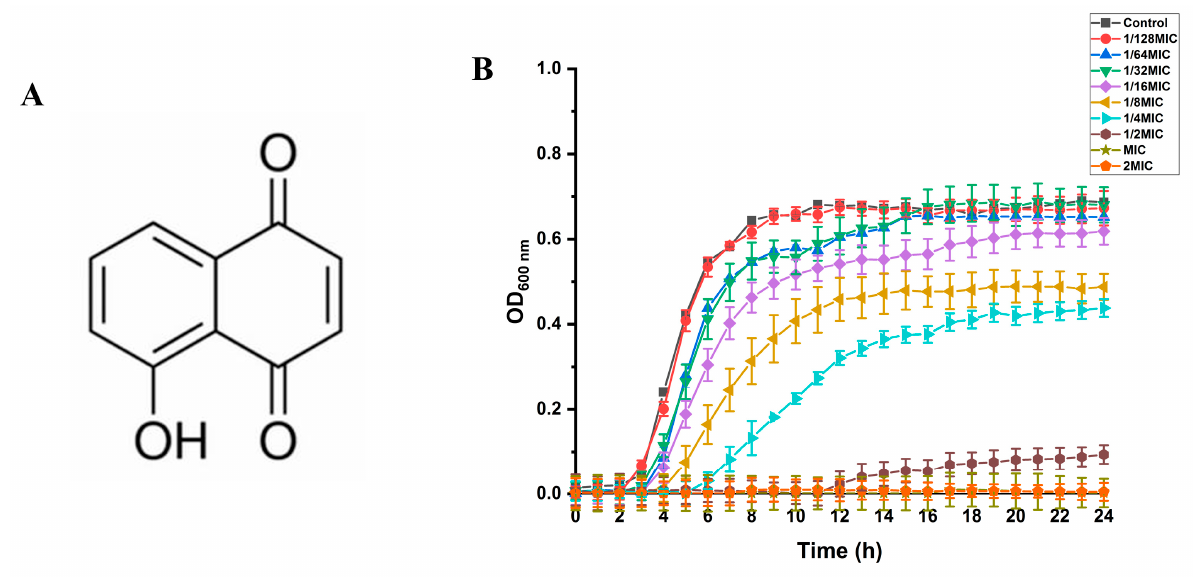
Figure 1. ( A ) Molecular structural formula of juglone. ( B ) The effect of juglone on the growth curve of S. aureus .